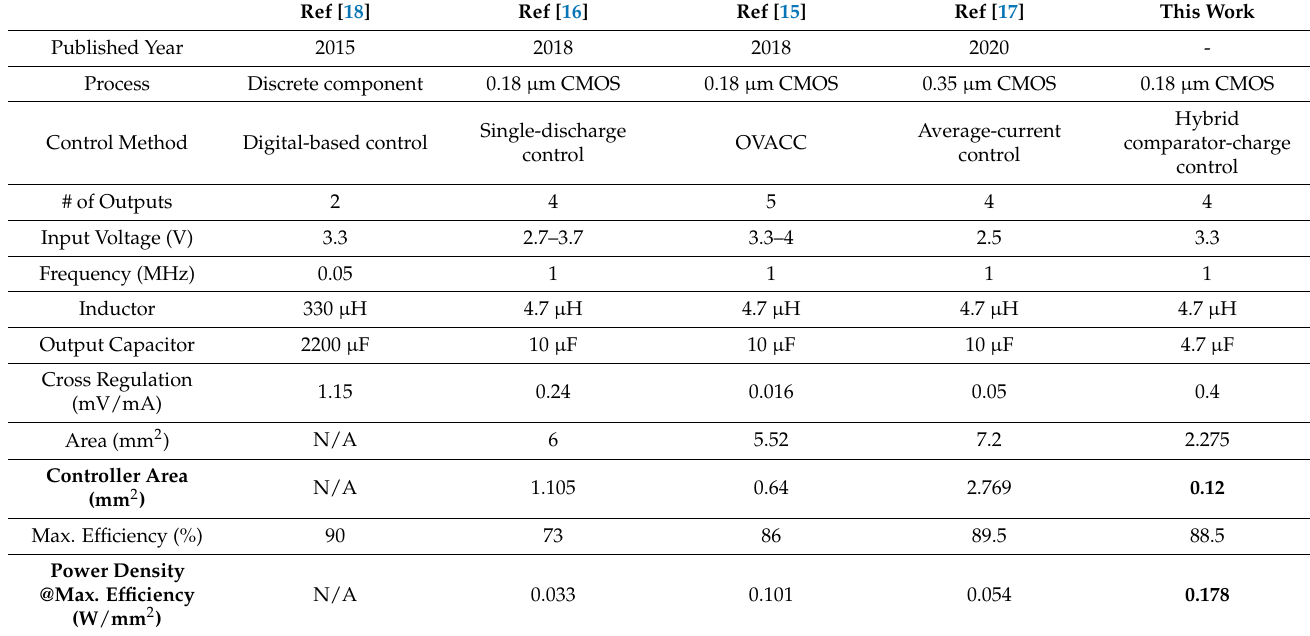
Table 3. Comparison with previous state-of-the-art